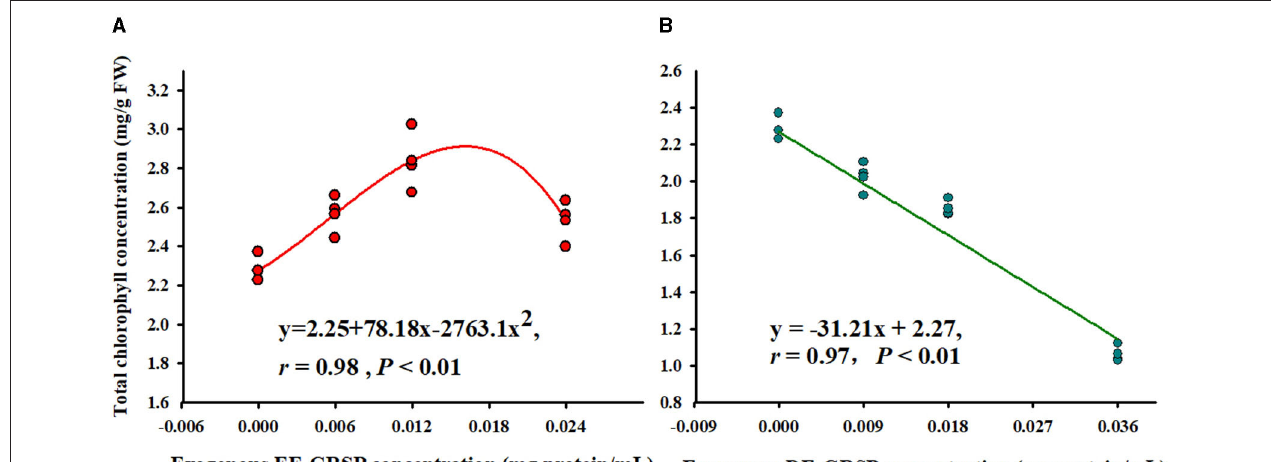
FIGURE 3 | Correlation between exogenous EE-GRSP (A) and exogenous DE-GRSP (B) and total chlorophyll concentration ( n = 16). DE-GRSP, difficultly extractable glomalin-related soil protein; EE-GRSP, easily extractable glomalin-related soil protein.